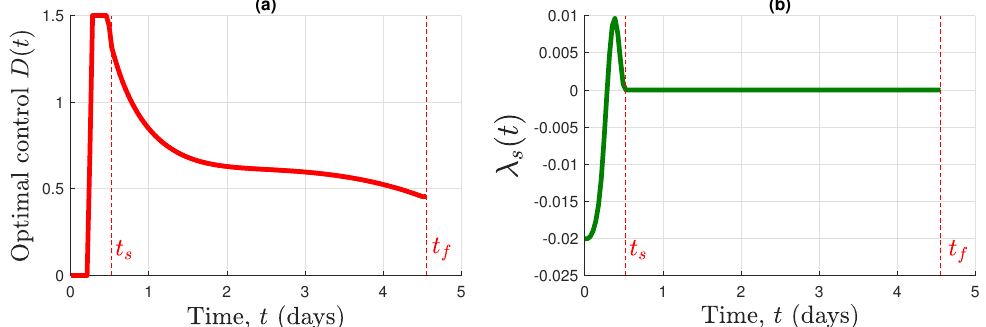
Figure 11. The optimal control given in ( a ) is bang(0)-bang(D max )-singular over [ 0, t f ) , where t f = 4.5541 days. A first switching instant from bang(0) to bang(D max ) occurs around 0.3 days, then t s occurs when λ s = 0, as illustrated in ( b ), starting the singular arc that steers the model trajectories towards T , with ε =